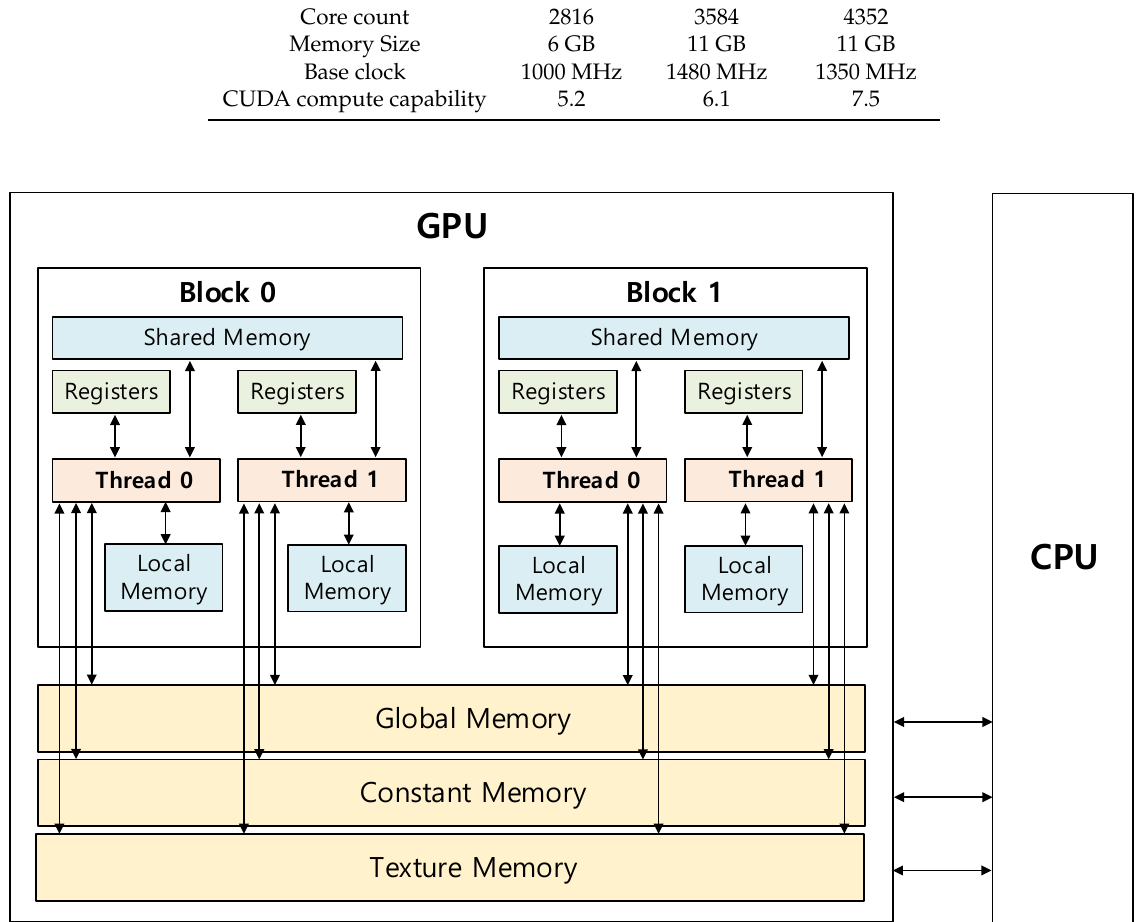
Figure 3. Nvidia GPU memory